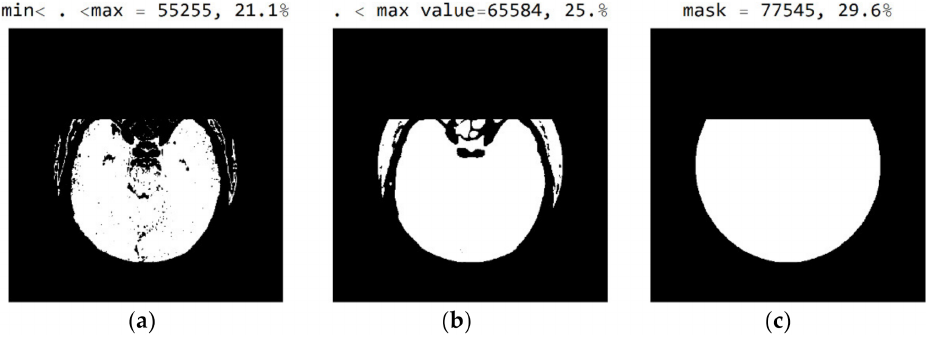
Figure 10. White represent pixels that will display the correct values for the selected mask: ( a ) in the range from the minimum to the maximum selected value; ( b ) in the range of values from 1 to 55; and ( c ) in the part of the image for a selected